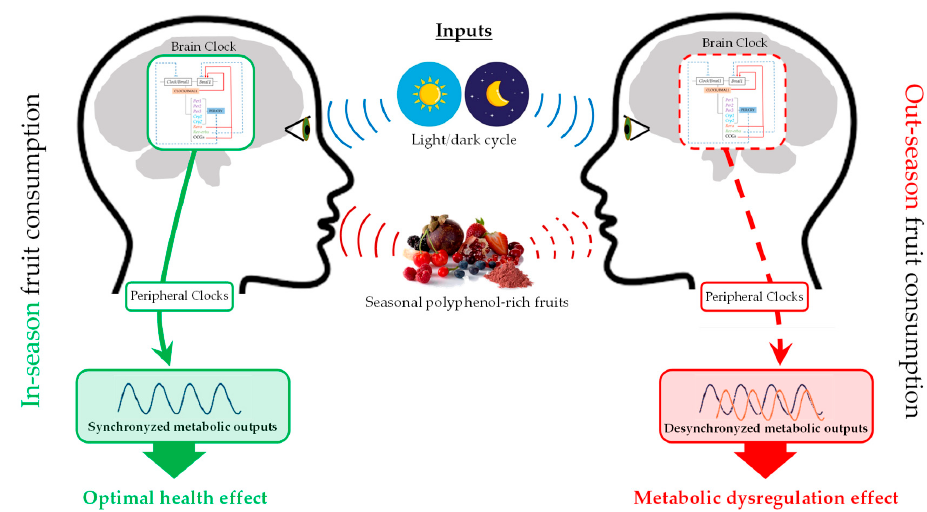
Figure 3. Interaction between gene regulation of biological rhythms, seasonal variation of plant polyphenols composition, and health seasonal effects.